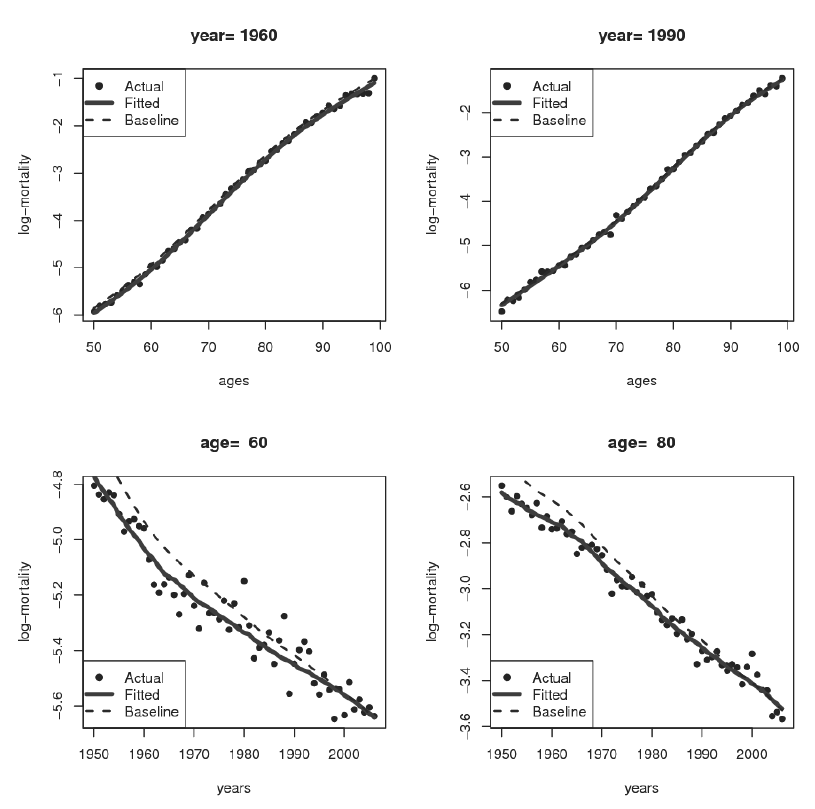
Figura 3 – Observed and fitted mortality rates for selected years and ages. Ip = H and Ic = m 0 . Swe- den,